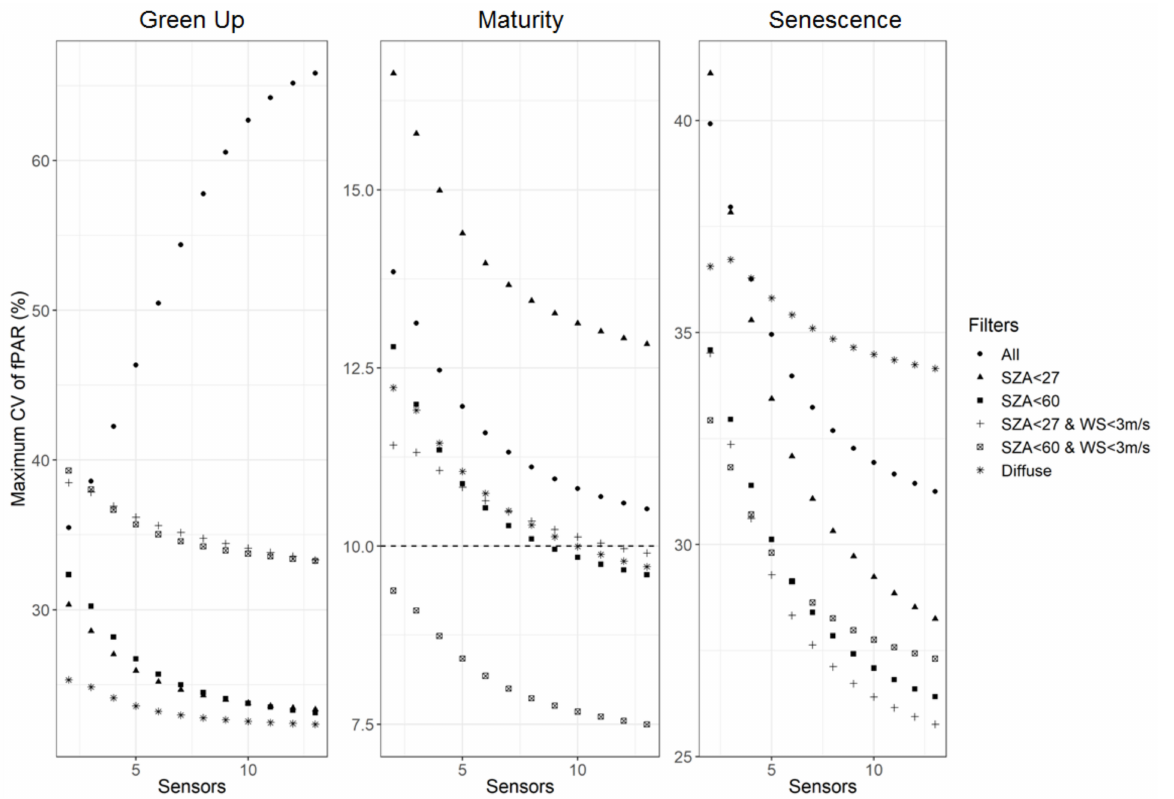
Figure 5. The coefficient of variation in the 2-flux domain fPAR is based on the number of sensors, data filtering, and phenophase. During green-up ( left ) the diffuse light has the lowest CV; however, no number of sensors reduces variation to below the 10% threshold. During maturity ( center ), two sensors are needed to meet the threshold at a high SZA and low wind speed; however, eight sensors are required in other circumstances. In senescence ( right ), there is no number of sensors or amount of filtering that will reach the threshold, but a low SZA and wind speed results in the lowest